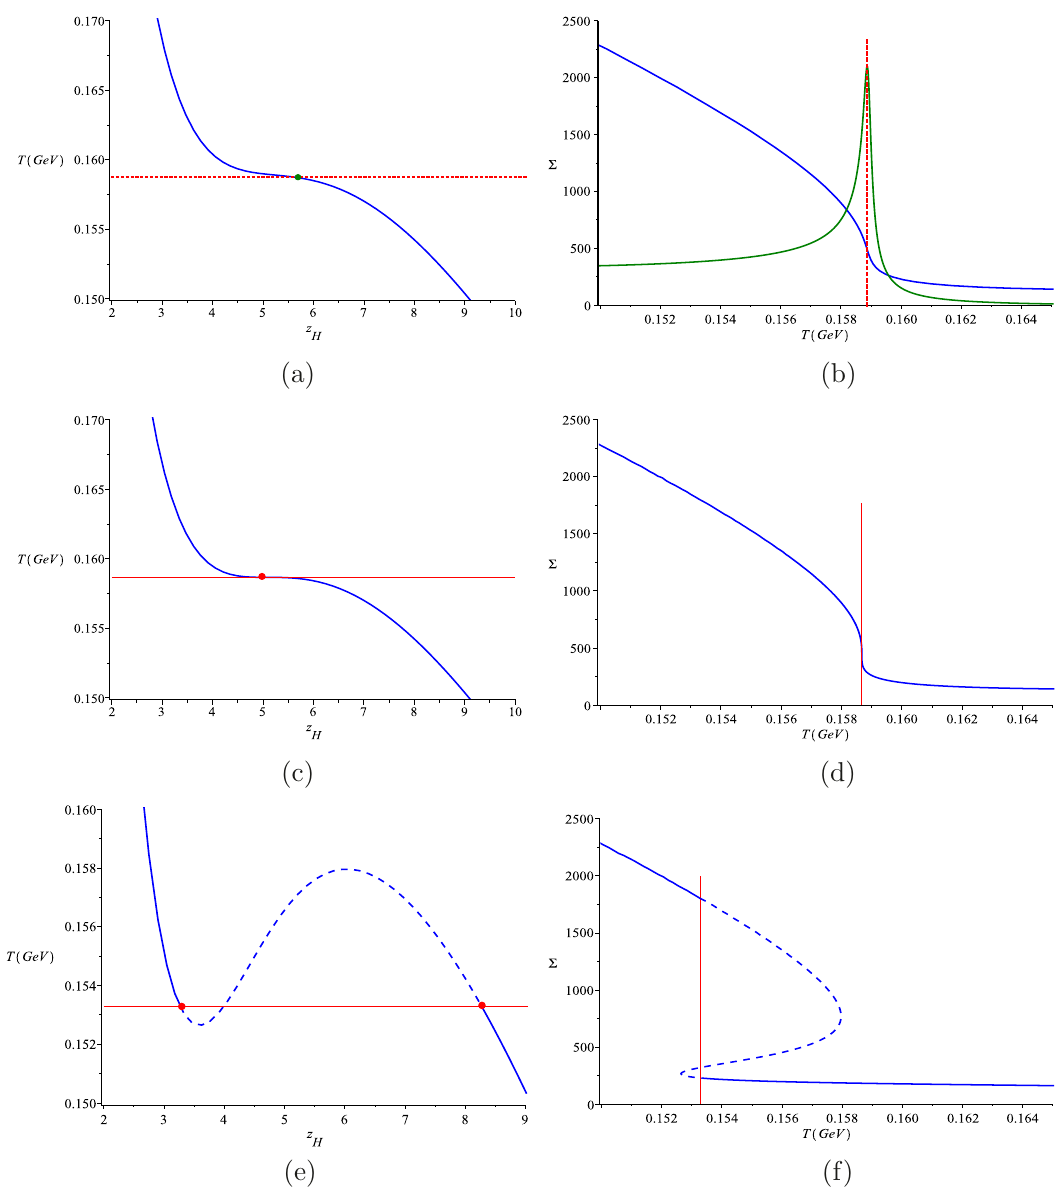
Figure 7 . The black hole temperature vs. horizon and the quark condensation vs. temperature for chemical potential at µ = 0 (a,b), µ = µ c (c,d) and µ = 0 . 6 (e,f). At µ = 0, both black hole temperature and quark condensation are monotonous. The green line represents the derivative of the quark condensation with the transition temperature labeled by the red dashed line at its peak. At µ = µ c , there is a saddle point at the critical temperature which causes the derivative of condensation divergent. For µ > µ c , the multi-valued behavior implies a black hole phase transition between two horizons labelled by the red dots in (e). The dashed blue curves indicate the unstable region which is bypassed by the black hole phase transition. The bypass mechanism forces the quark condensation phase transition takes place at the same temperature of black hole phase transition in